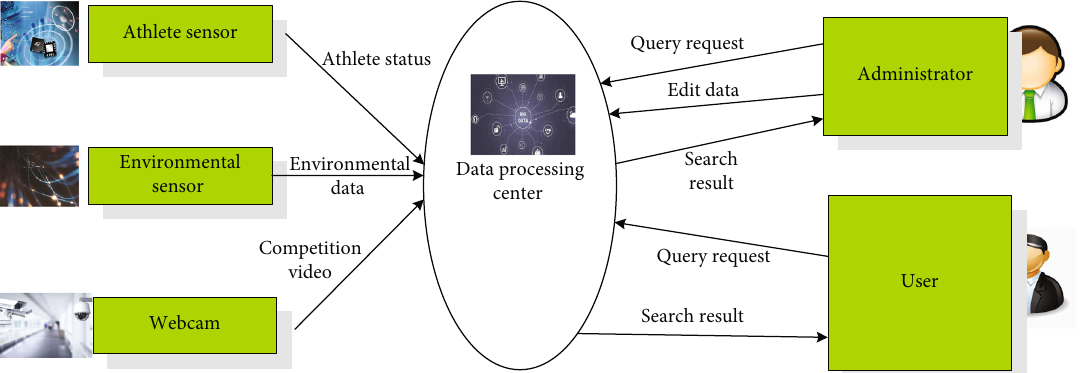
Figure 1: Data fl ow diagram-top level diagram.